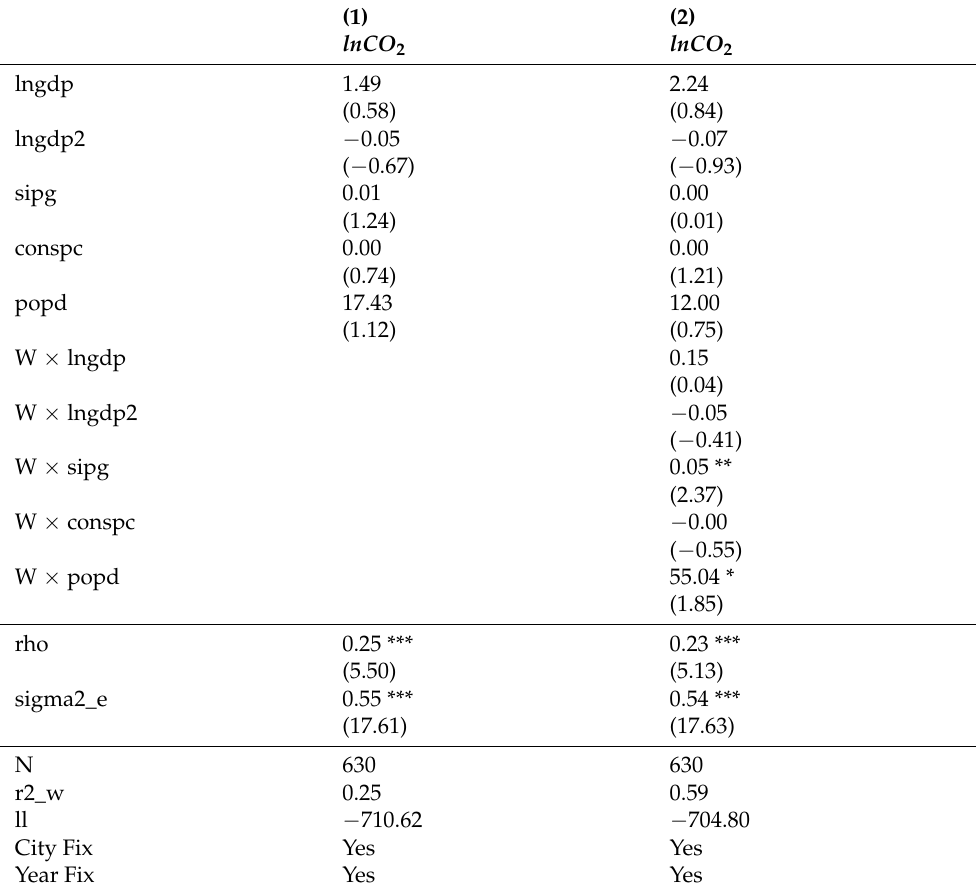
Table 5. Robustness test—Change in the spatial weight